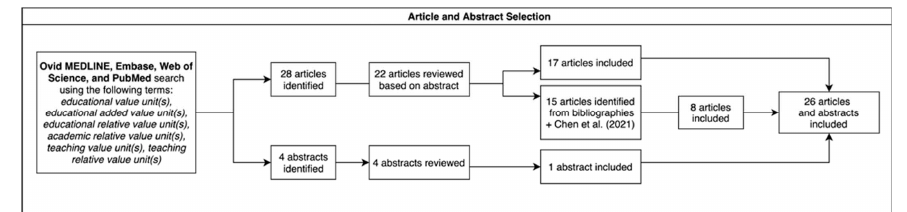
Figure 1. Method of article and abstract selection based on searches conducted in Ovid MEDLINE, EMBASE, Web of Science, and PubMed databases. Search results were examined to select articles and abstracts for review, and additional articles were identified from bibliographies of selected articles. Chen et al. (2021) [13] was selected for review independently of the above search due to prior knowledge of article content.